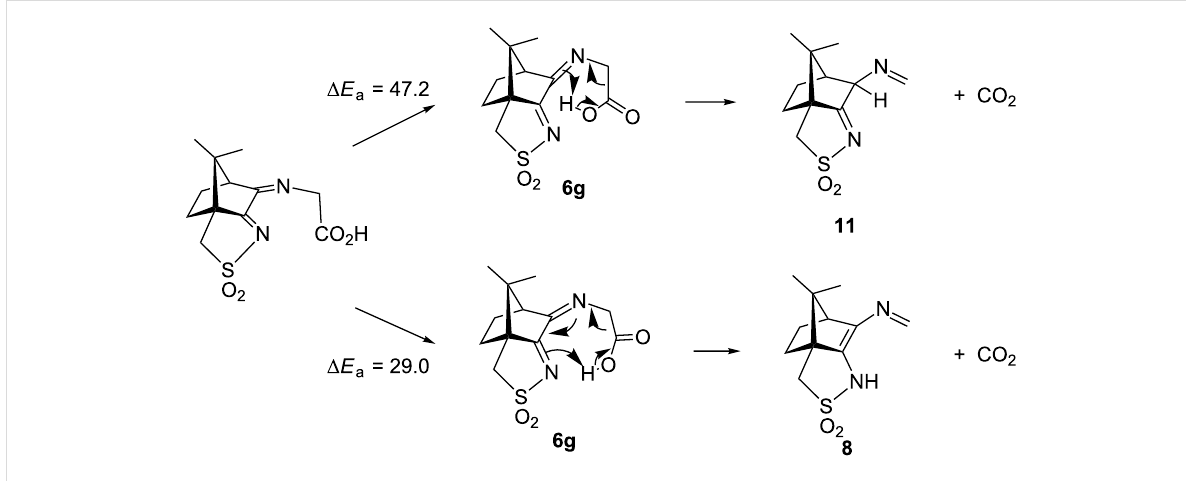
Figure 8: Intramolecular reactions of non-zwitterionic ground state 6g to 11 (top) or 8 (bottom). The activation energy Δ E a denotes the calculated energy difference (in kcal/mol) between the TS and the optimized ground state 6g . A similar activation barrier was found for the conversion 6g → 10 (50.3 kcal/mol).